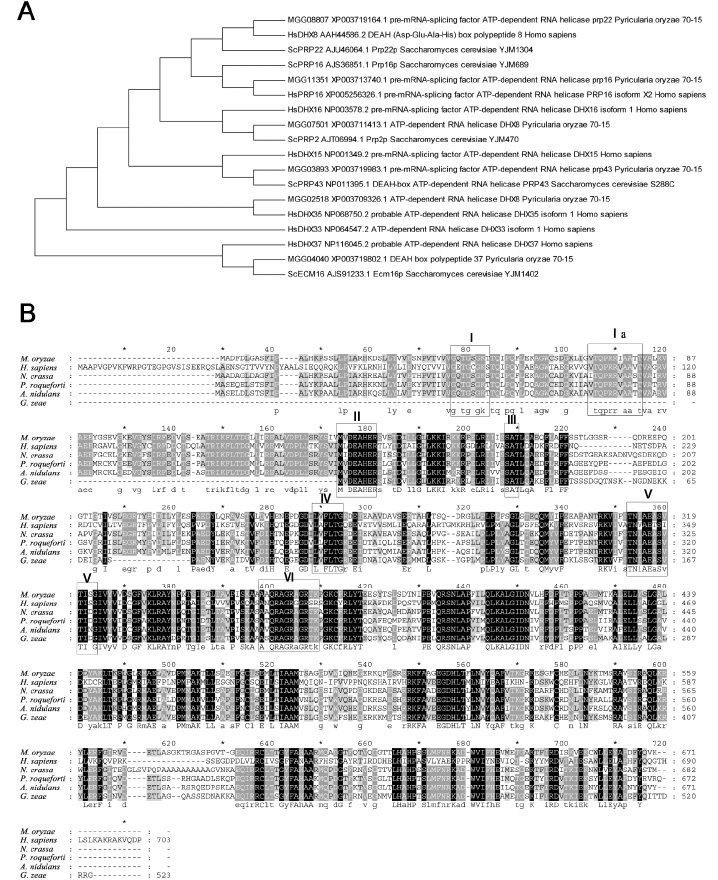
Figure 1. Similarity of MoDHX35 homologs. ( A ) Phylogenetic relationship of MoDHX35 (MGG_02518) and its closely related proteins in Magnaporthe oryzae , Saccharomyces cerevisiae and Homo species , calculated with neighbor ‐ joining method using the MEGA 5.0 program. ( B ) Amino acid sequences of HsDHX35 (NP_068750.2) from humans, NcDHX35 (XP_963507.1) from Neurospora crassa , PrDHX35 (XP_038929158.1) from Penicillium roqueforti , AnDHX35 (EHA17759.1) from Aspergillus nidulans and GzDHX35 (XP_381721.1) from Gibberella zeae ( Fusarium graminearum ) were aligned using Clustal W. The identical amino acids are highlighted against a black background, conserved residues are shown on a dark gray background, and similar residues on a light gray background.